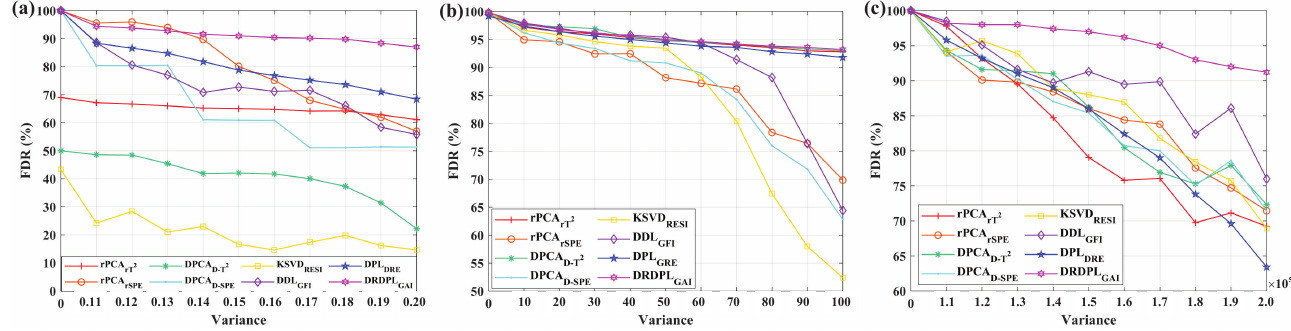
Figure 17. FDR of each method with varying variance. ( a ) Numerical simulation; ( b ) TE process with IDV (6); ( c ) Aluminum electrolysis process with anode